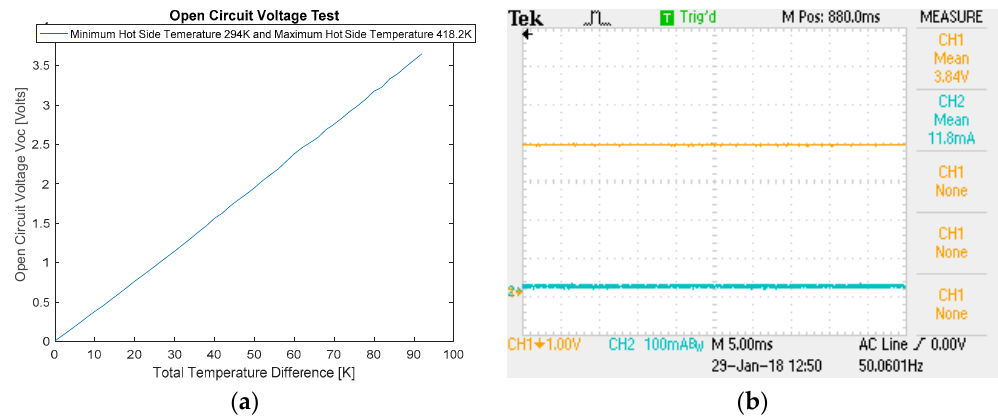
Figure 11. ( a ) Effect of temperature difference ( Δ𝑇 ) on open circuit voltage ( V oc ) and ( b ) oscilloscope DC V oc and I oc response at 418.2 K (or Δ𝑇 of 92 K).